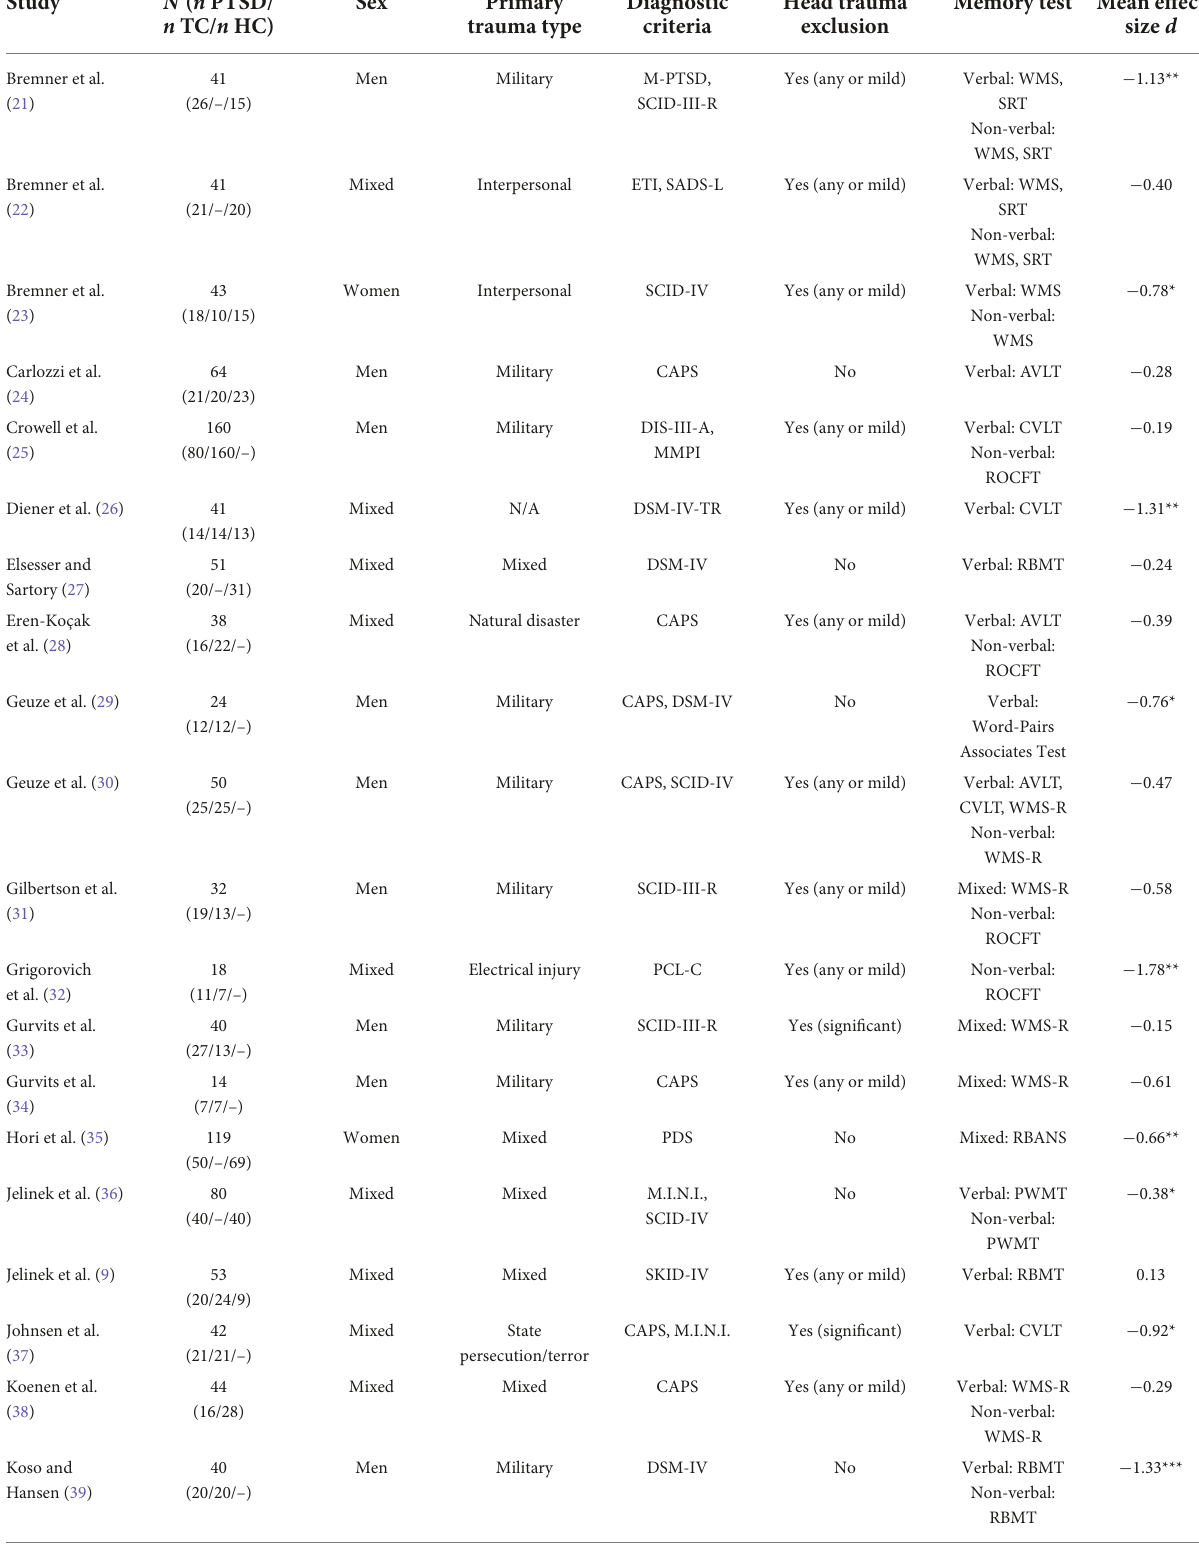
TABLE 1 Overview of studies included in the